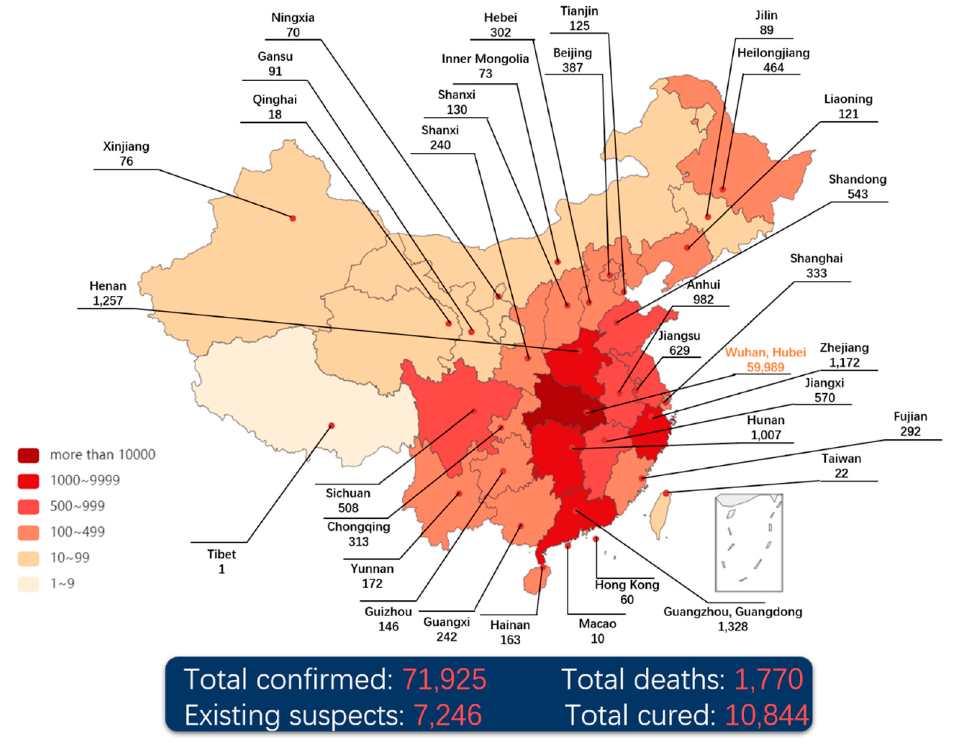
Figure 1. The heat map of coronavirus disease 2019 (COVID-19) in China (till 24:00 17 February 2020).